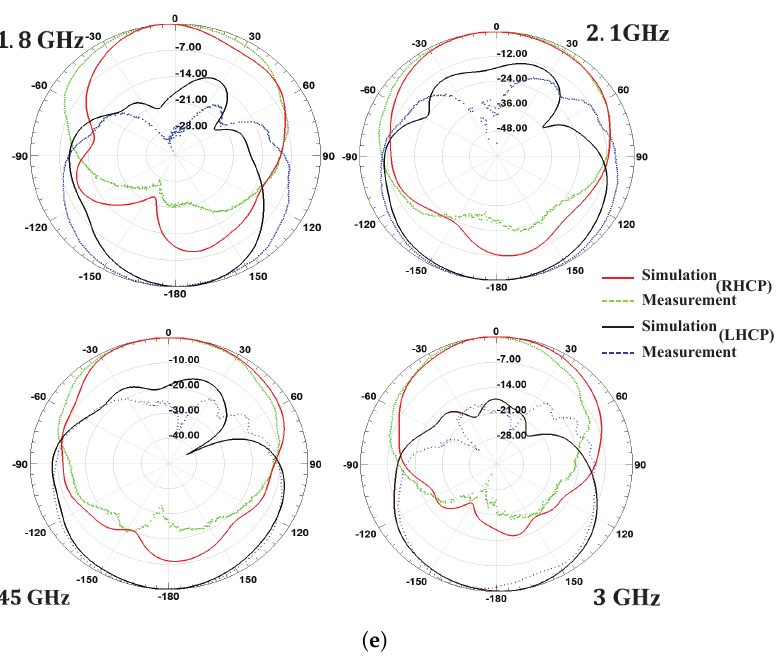
Figure 3. Antenna simulation and measurement performance characteristics, ( a ) Measurement set-up, ( b ) Input reflection coefficient S 11 , ( c ) Axial ratio AR, ( d ) Realized gain, and ( e ) E-plane radiation